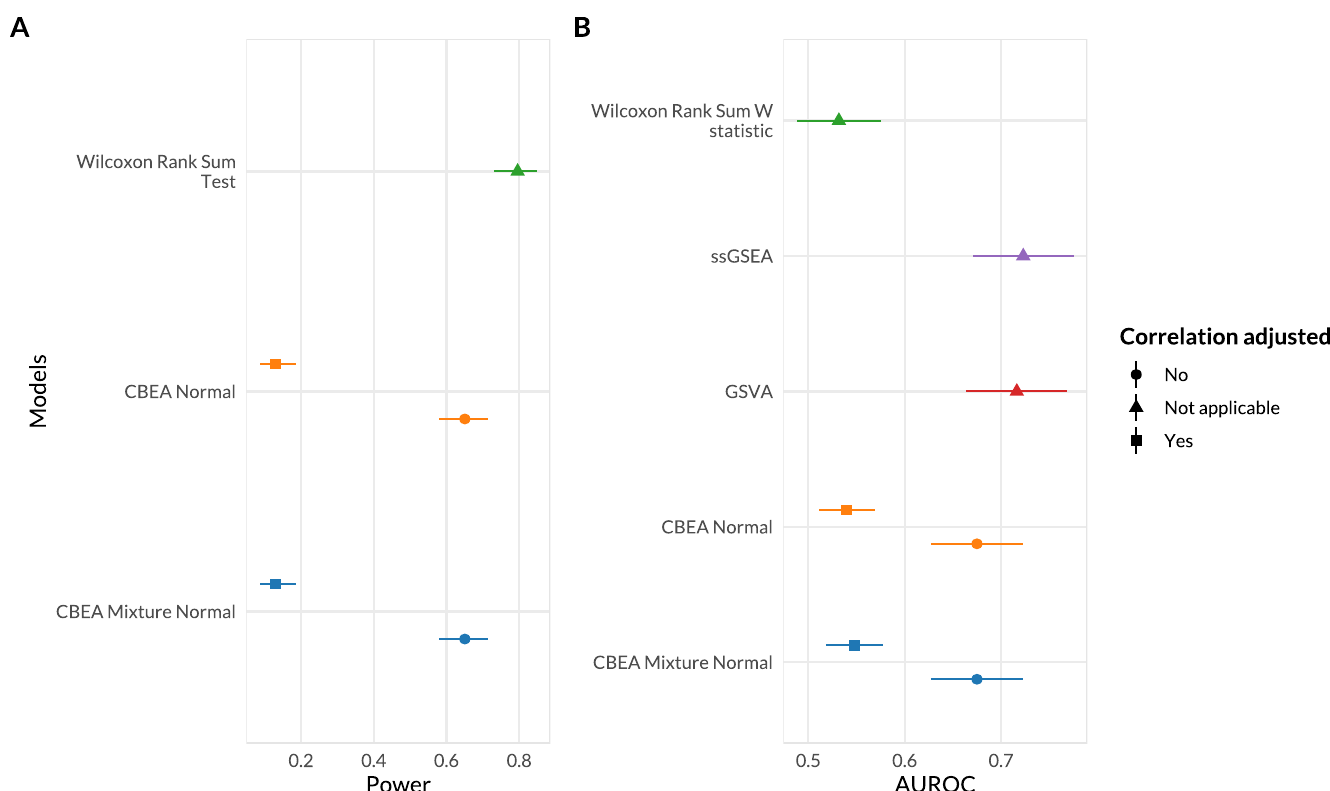
Fig 4. Statistical power (A) and score rankings (B) to assess phenotype relevance. ( A ) Power ( x -axis) was estimated as the overall fraction of aerobic microbes found to be enriched in supragingival samples at α = 0.05. 95% confidence intervals were computed using the Agresti-Couli approach for binomial proportions. ( B ) Score rankings were evaluated by comparing computed scores against true values using AUROC ( x -axis). DeLong 95% confidence intervals for AUROC were computed.